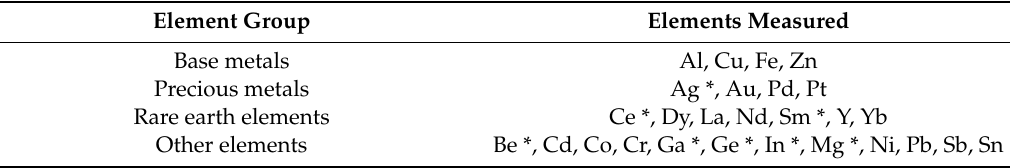
Table 2. Elements